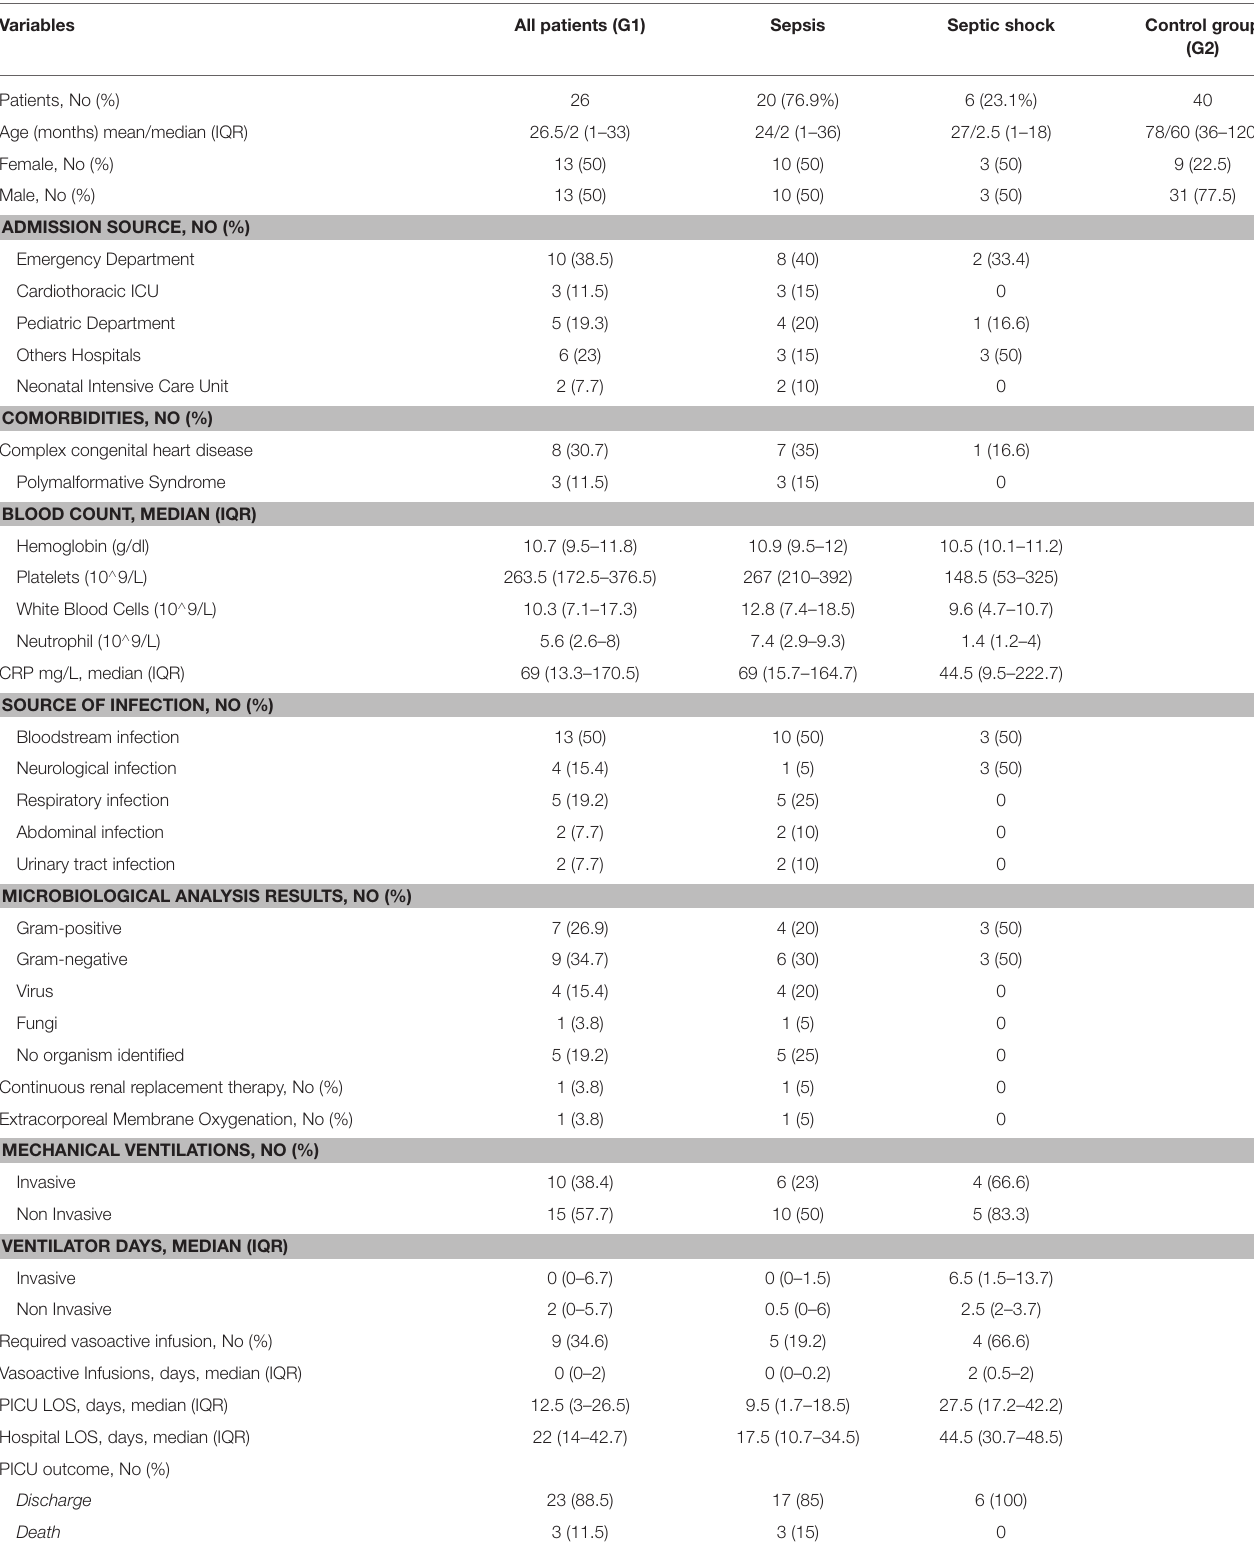
TABLE 1 | Demographics and clinical characteristic of 26 sepsis/septic shock patients (G1 group) and control group (G2).